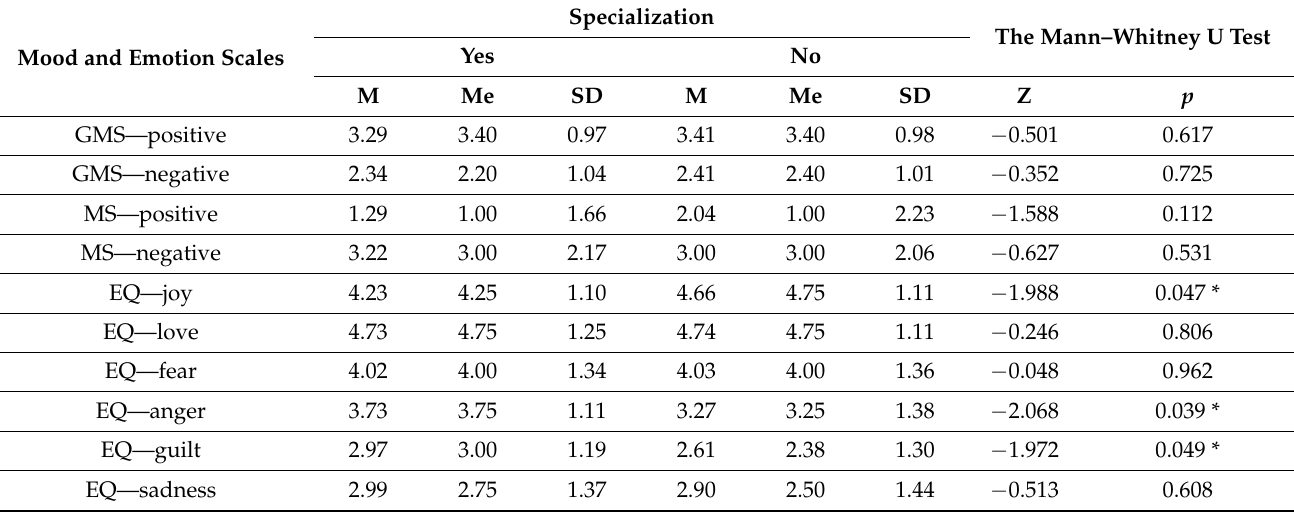
Table 5. Having a specialization and the mood and